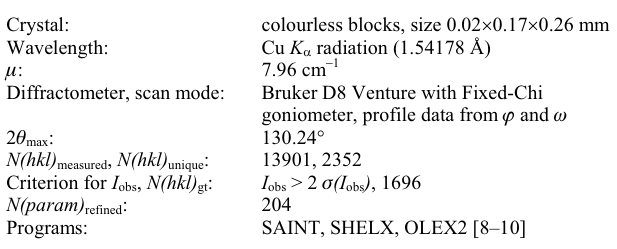
Table 1. Data collection and